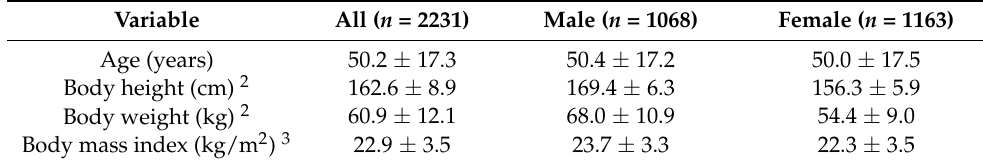
Table 1. Basic characteristics of the study population 1